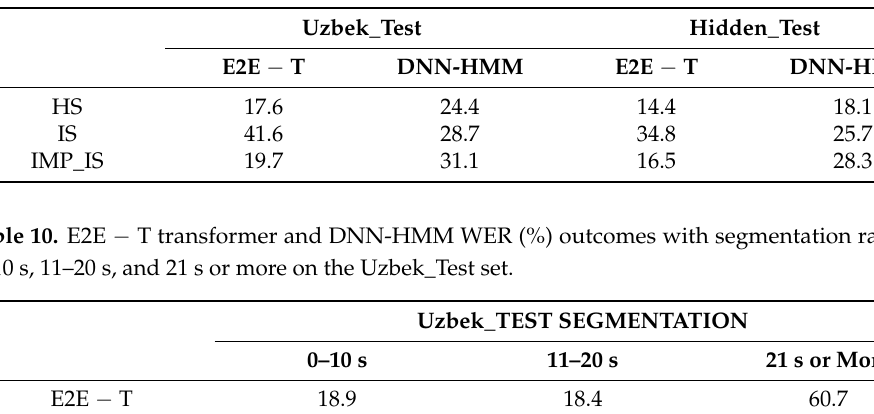
Table 9. Human segmentation, InaSpeech segmentation, and the proposed improved InaSpeech segmentation are all benchmarked using the E2E − T transformer and the DNN-HMM WER (%) results on two sets: Uzbek Test and Hidden Test.